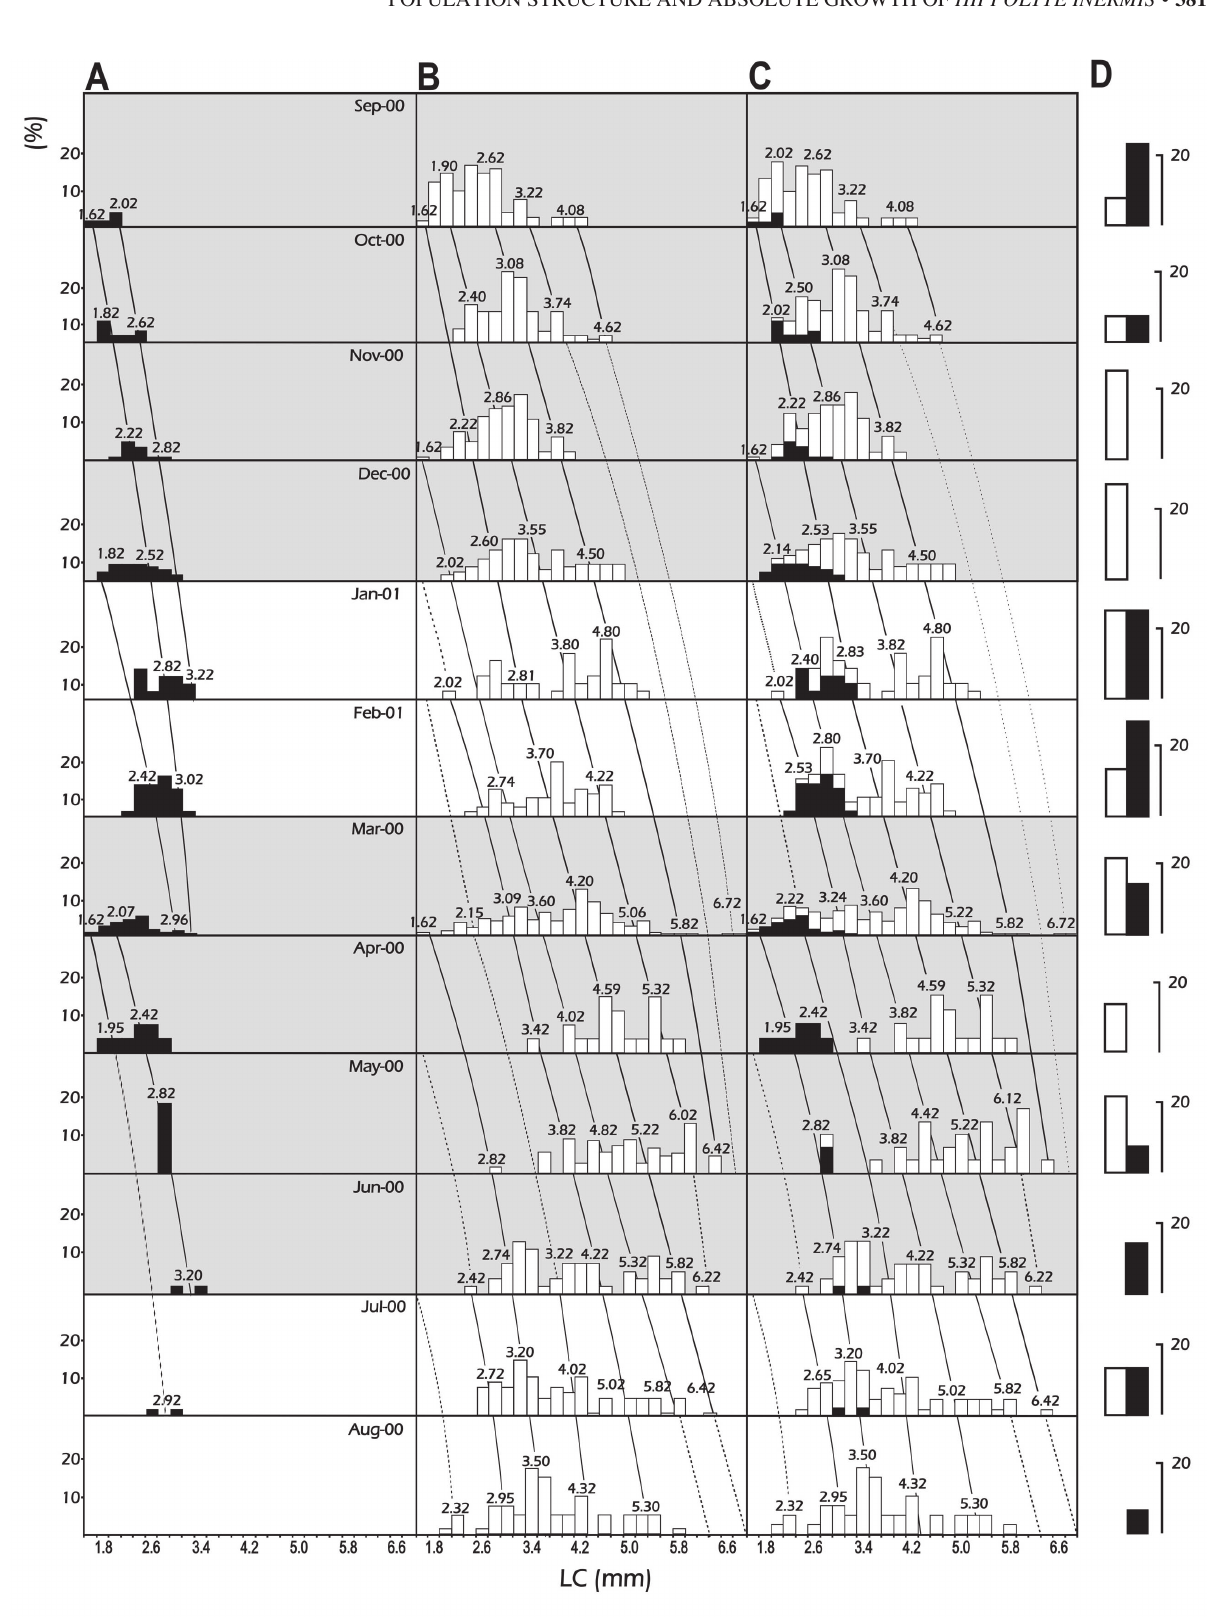
Fig . 4. – Frequency histograms of size classes. size evolutions are indicated with diagonal lines between the mean size values of the cohorts. a: males; b: females; C: whole population. D: Monthly evolution of embryo development stages. 1 (white): earliest stage. 6 (black): last